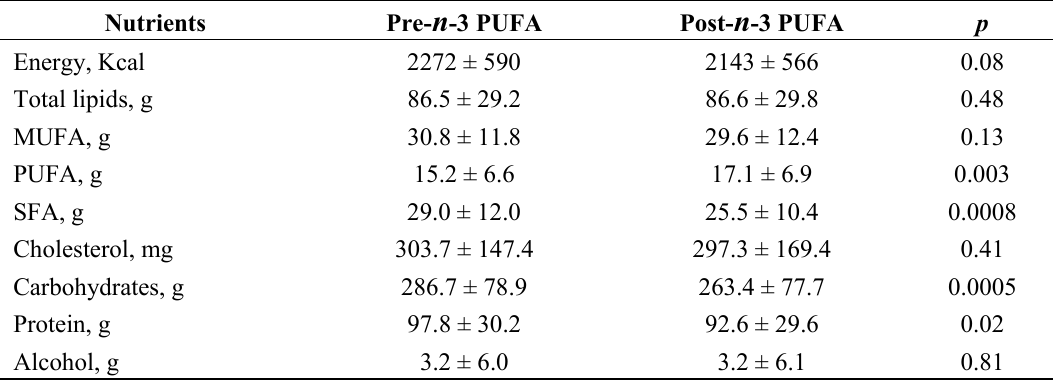
Table 3. Daily intakes from food frequency questionnaire ( n =